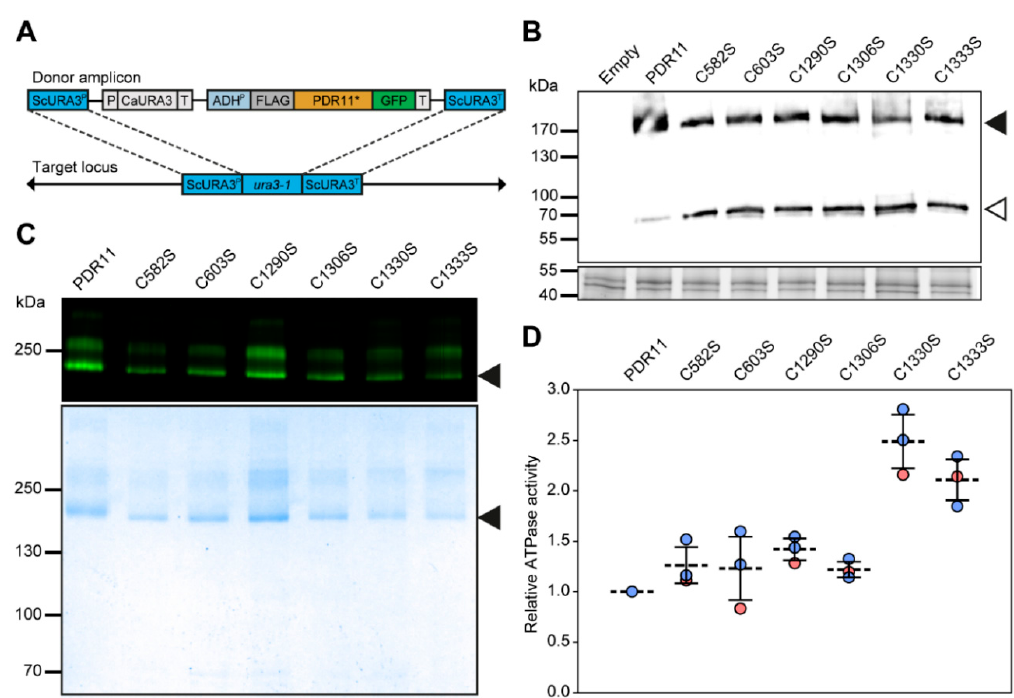
Figure 2. Expression and purification of Pdr11p cysteine mutants. ( A ) Genomic integration of a FLAG-PDR11-GFP cassette containing the URA3 gene from Candida albicans ( Ca URA3) at the deleted URA3 locus in hem1 ∆ aus1 ∆ pdr11 ∆ cells. Integration was achieved by homologous recombination between the URA3 promoter (URA3P) and terminator (URA3T) regions [10]. P, promoter; T, terminator; *, pdr11C582S , pdr11C603S , pdr11C1290S , pdr11C1306S , pdr11C1330S , pdr11C1333S . ( B ) Immunoblot (upper panel) illustrating the plasmid-based expression of FLAG-tagged wild-type and mutant Pdr11p-GFP (filled arrowhead) and breakdown product (open arrowhead). Cells transformed with empty plasmids were used as a control. Blots were probed with anti-FLAG tag antibody. In-gel fluorescence detection (lower panel) using Criterion TGX stain-free gels served as the loading control. ( C ) SDS–PAGE gel representative of at least two purifications of the Pdr11p-GFP and mutant variants first analyzed by in-gel fluorescence (upper panel) and then by Coomassie blue staining (lower panel). ( D ) ATPase activity of purified Pdr11p-GFP and mutant variants was assayed as described in materials and methods using [ γ -32P] ATP. Results are the means ± SD of triplicates from two independent purifications (red symbols, 1st purification; blue symbols, 2nd purification) and expressed relative to the value obtained for wild-type Pdr11p. Background signal for each experiment was subtracted from all sample measurements before calculation. A ratio of 1 corresponds to 0.25 ± 0.08 µ mol/min/mg. The ATPase-inactive mutant Pdr11pK788M showed very low background ATPase activity (7 ± 2% relative to wild type,